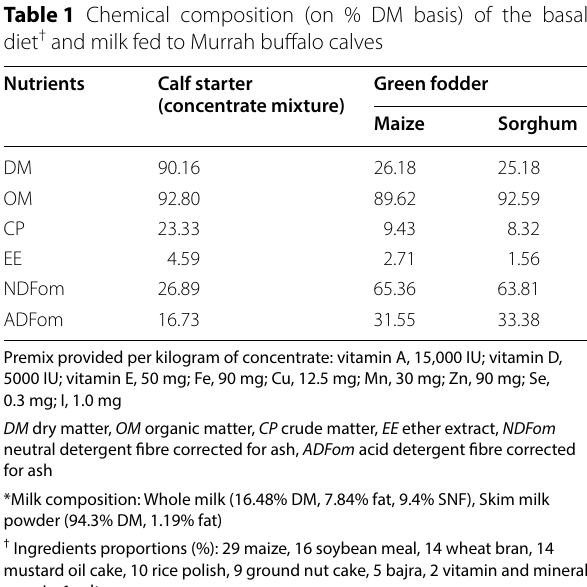
Table 1 Chemical composition (on % DM basis) of the basal diet † and milk fed to Murrah buffalo calves